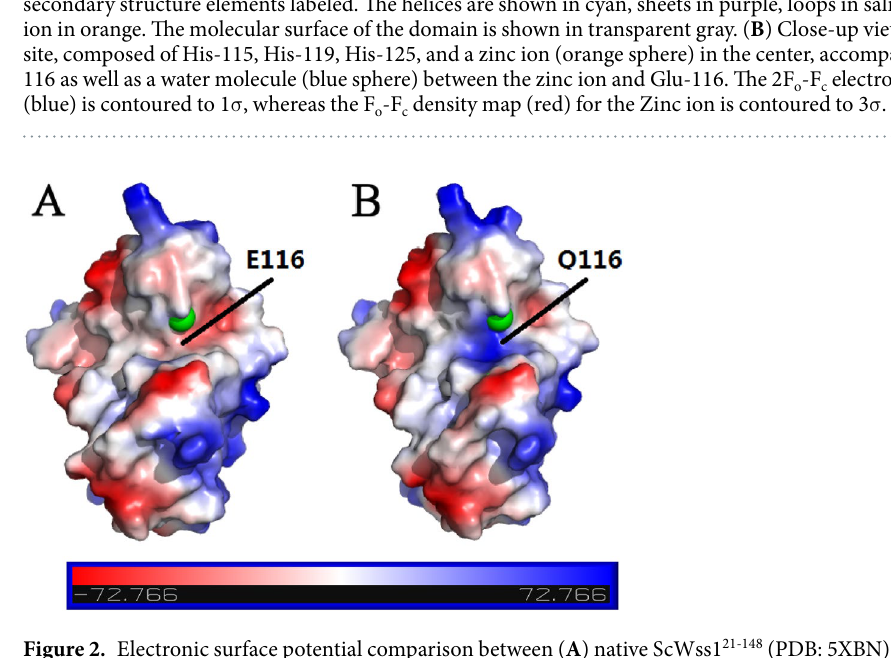
Solution structure of full-length ScWss1. SAXS experiment was further applied to investigate the struc- ture of full-length ScWss1 in solution. Before SAXS data collection, the purity and homogeneity of the protein was confirmed by dynamic light scattering (DLS, Fig. S3A), which demonstrated the diameter of the protein particle of about 75 Å (Fig. S3B). SAXS profile of the full-length ScWss1 is shown in Fig. 3A. Corresponding structural parameters that are derived from the SAXS data are listed in Table 2. Molecule mass calculated from the SAXS data is 35 kDa, approximately equal to the theoretical molecule mass calculated from the sequence (31 kDa), meaning the full-length protein exists as monomer in solution. Low resolution SAXS model of the full-length protein was further built based on the p ( r ) function (Fig. 3A, left below insert) using program GASBOR (Fig. 3B). Ten independent models gave reproducible results (NSD av = 1.25) and demonstrated good approximations to the experimental data with discrepancy value of chi 2 = 2.5. The final model displayed an ellipsoidal shape for the full-length protein (Fig. 3B), indicating the fragments that are missing in the crystal protruded from the catalytic core into solution, probably for substrates searching and binding activities. The part that was invisible or degraded in the crystal was predicted to contain a lot of loops and flexible structures inside. Therefore, we also use an ensemble of conformers to characterize the system. Using the pro- gram EOM, a large pool of 10,000 different conformations is generated to analyze the flexibility of the full-length ScWss1, and an optimized ensemble of 50 models that best describes the SAXS data are selected. The selected ensemble of conformations fit the experimental data with chi 2 = 1.046. The R g distribution profile calculated from the optimized ensemble contains a main peak at the low R g region and a dispersion peak at the high R g region